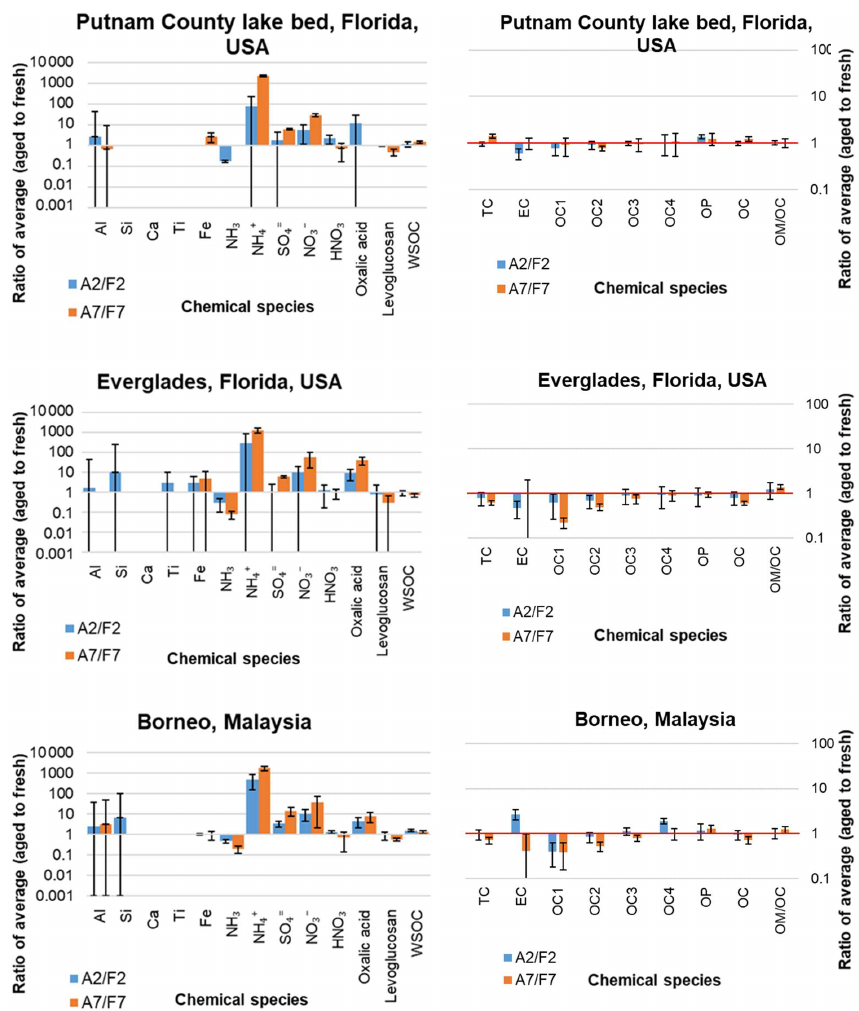
Figure 3. Ratios of average aged (A) to fresh (F) chemical species for 2d (A2/F2) and 7d (A7/F7) of atmospheric aging for six types of peats. Error bars represent the standard deviations associated with each ratio. Note that different scales were used for the two Y axes, with 0.001 to 10000 on the left axis and 0.1 to 100 on the right axis (species abbreviations are shown in Table 1; OM is organic